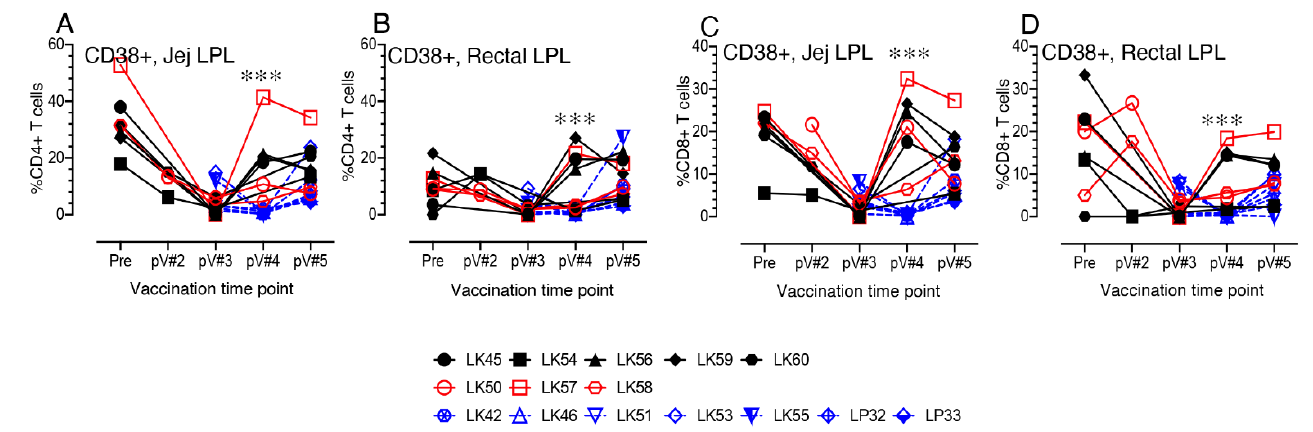
Figure 6. Dynamics of CD38+ activated T cell populations during vaccination and post SIV infection in vaccinated and control macaques in mucosal tissues. Frequency of activating CD4+ ( A , B ) and CD8+ ( C , D ) jejunal and rectal T cells are shown for both vaccinated and control macaques. A significant upregulation of activating CD4 and CD8 T cells are detected in vaccinated animals compared to control animals at 2 weeks post vaccination 4 (pV#4) time point. Black and red lines represent vaccinated animals. Black and red lines represent vaccinated infected (VI) and vaccine protected (VP) macaques, respectively. Blue dashed lines represent control macaques. Asterisks denote statistically significant differences between vaccine and control groups for the specific time point (* p < 0.05, ** p < 0.01, and *** p < 0.001).